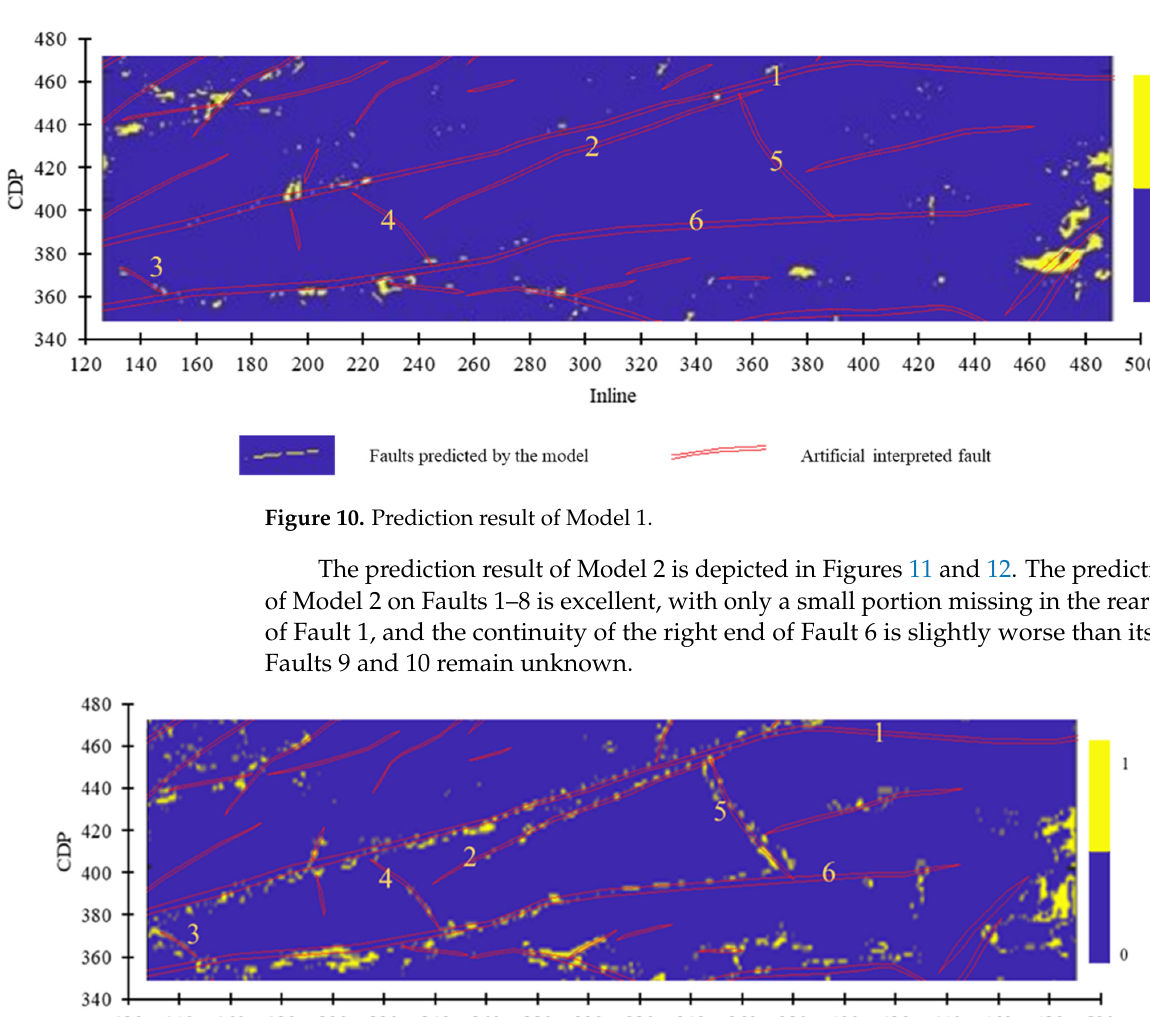
Figure 9. Ten faults in the mining area were selected for comparative experiment .